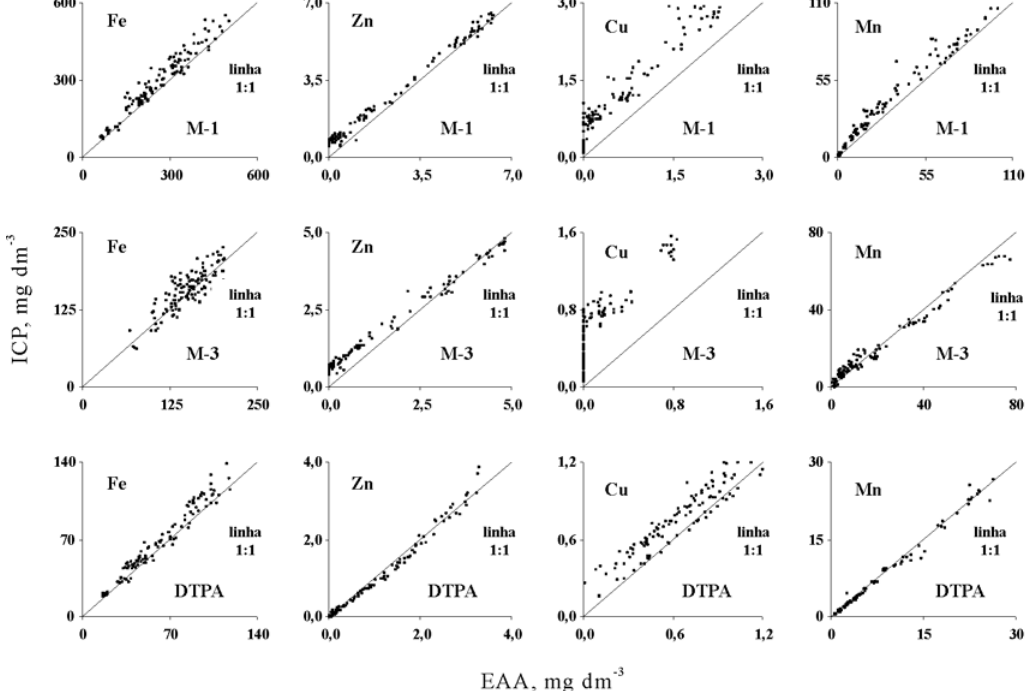
Figura 1. Relação entre os teores de Fe, Zn, Cu e Mn extraídos por Mehlich-1 (M-1), Mehlich-3 (M-3) e DTPA-TEA (DTPA) e dosados por espectrofotometria de emissão ótica em plasma induzido (ICP) e espectrofotometria de absorção atômica